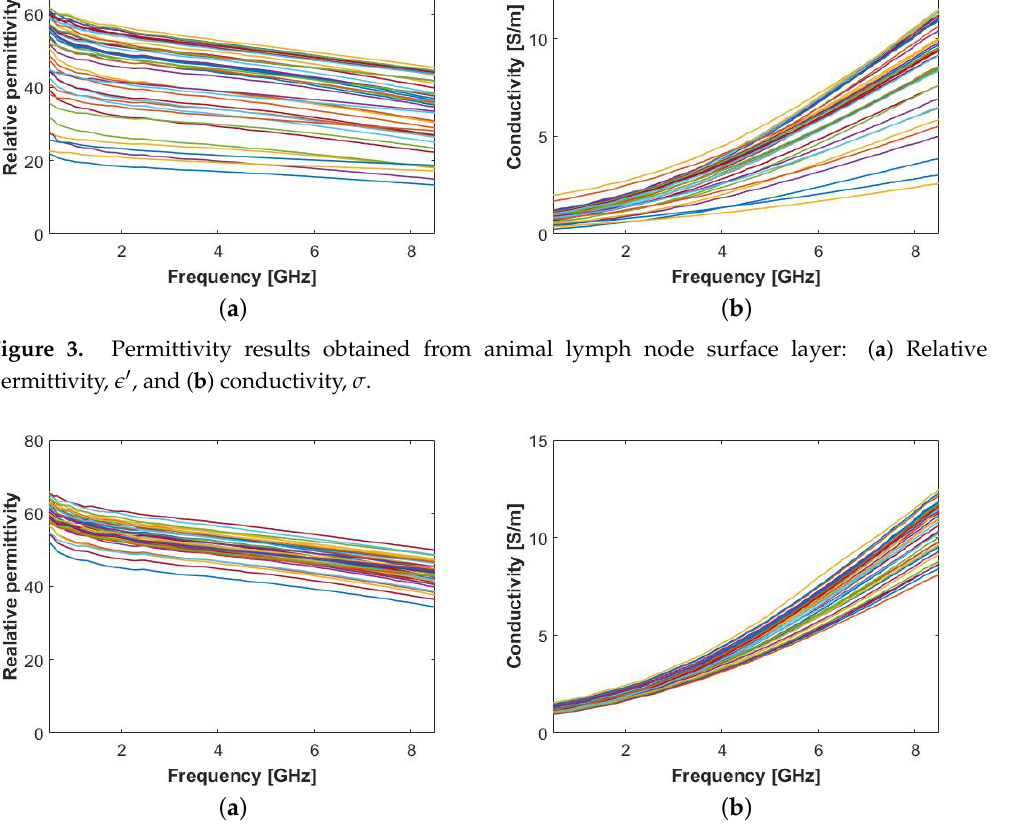
Figure 4. Permittivity results obtained from animal lymph node inner layer: ( a ) Relative permittivity, (cid:101) (cid:48) , and ( b ) conductivity, σ